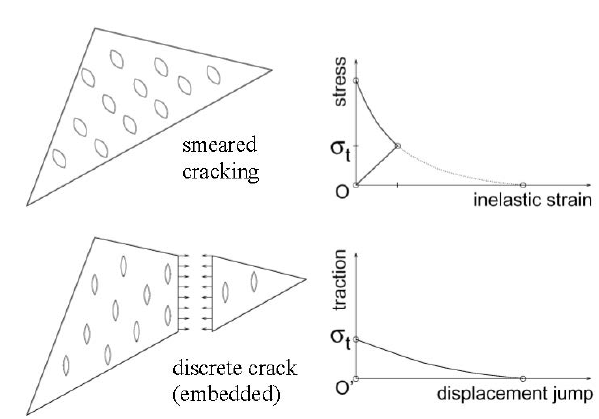
Figure 44: Transition from a continuum model to a discontinu- ity